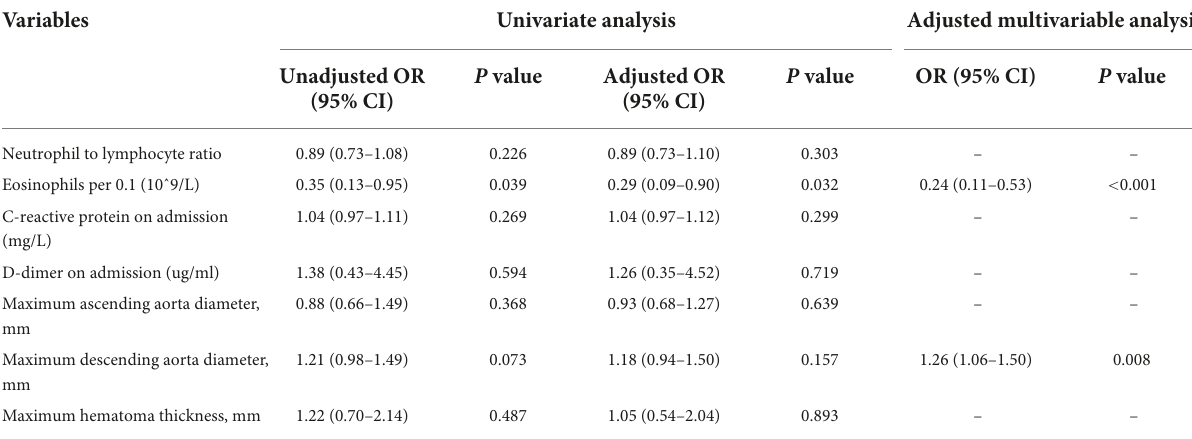
TABLE 3 Variables associated with aorta-related adverse events and aorta-related mortality ab . (A) Logistic regression analyses: significant predictors for aorta-related adverse events in the acute